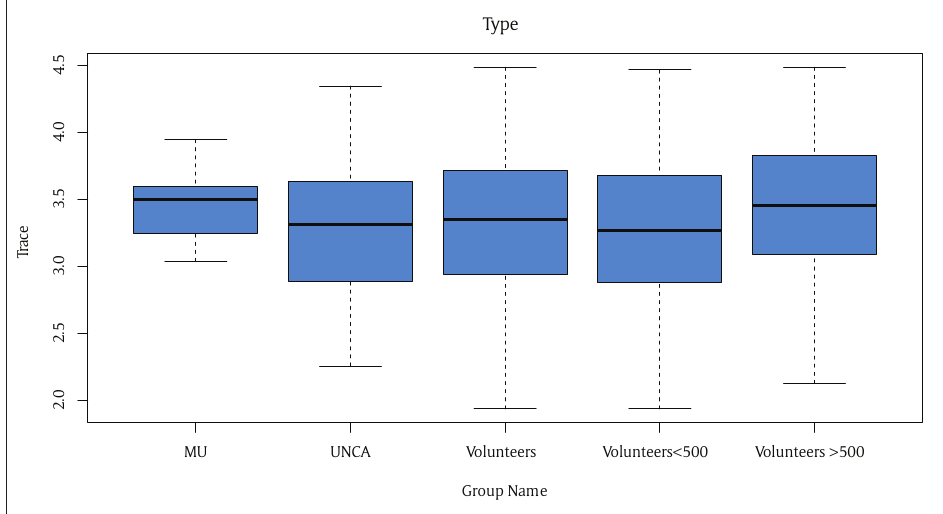
Figure 5: Boxplot of the results for the storm typing question (n = 6, so trace value bounded between 0 and 6). A trace value of 1 would represent completely random selections by the users and thus a complete lack of skill for this task. Table 6: Number of Volunteer subsamples whose mean had a p value of < 0.05 in comparison with either MU or UNCA for the three classification categories, given